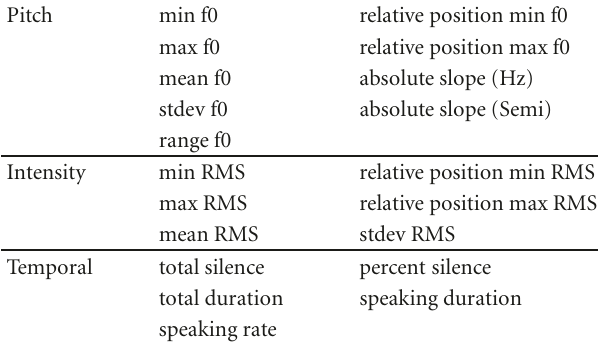
Table 1: In our experiments, we use a standard set of pitch, intensity, and temporal prosodic features.